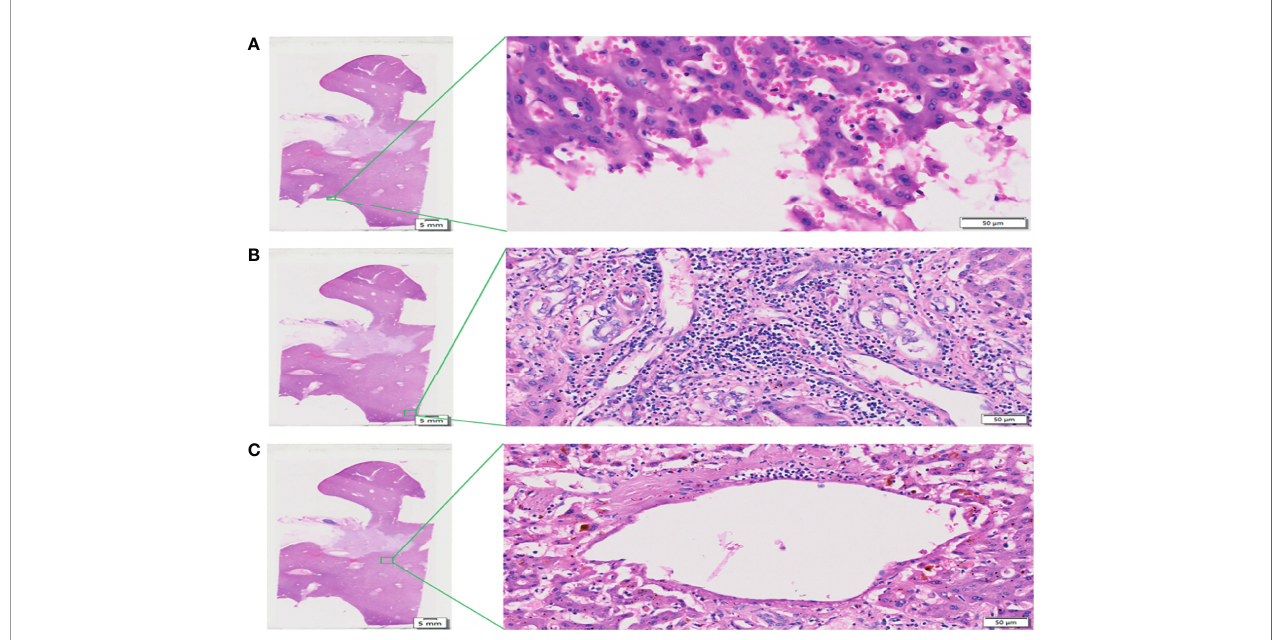
FIGURE 3 | View of the liver incision margin, distal peripheral portal area, and internal hepatic parenchyma of WHLS in HCCA. (A) Local liver incision margin. Scale bar, 50 µm. (B) Distal peripheral portal area. Scale bar, 50 µm. (C) Internal hepatic parenchyma. Scale bar, 50